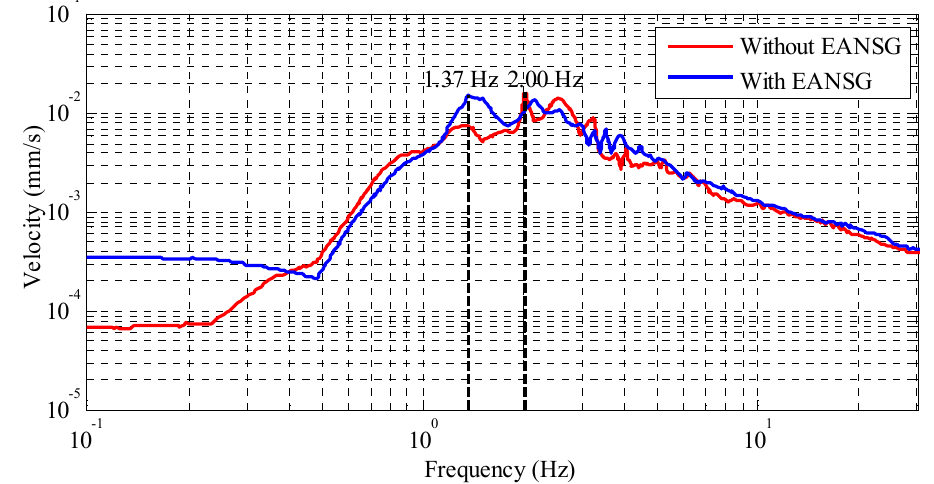
Figure 18. Spectrum analysis of the measured velocity impact responses.